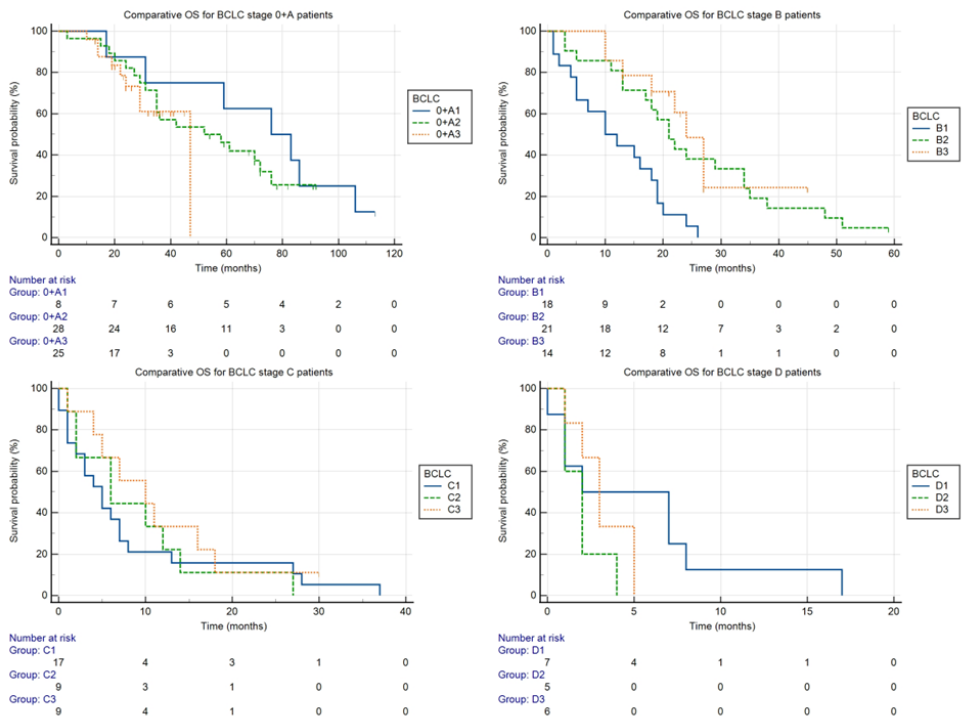
o Stage B: The differences between the median OS for groups B1, B2, and B3 (10, 21, and 24 months, respectively) were statistically significant ( p < 0.05). o Stage C: The differences between the median OS for groups C1, C2, and C3 (5, 6, and 10 months, respectively) were not statistically significant ( p = 0.61). o Stage D: The differences between the median OS for groups D1, D2, and D3 (2, 2, and 3 months, respectively) were not statistically significant ( p = 0.33).